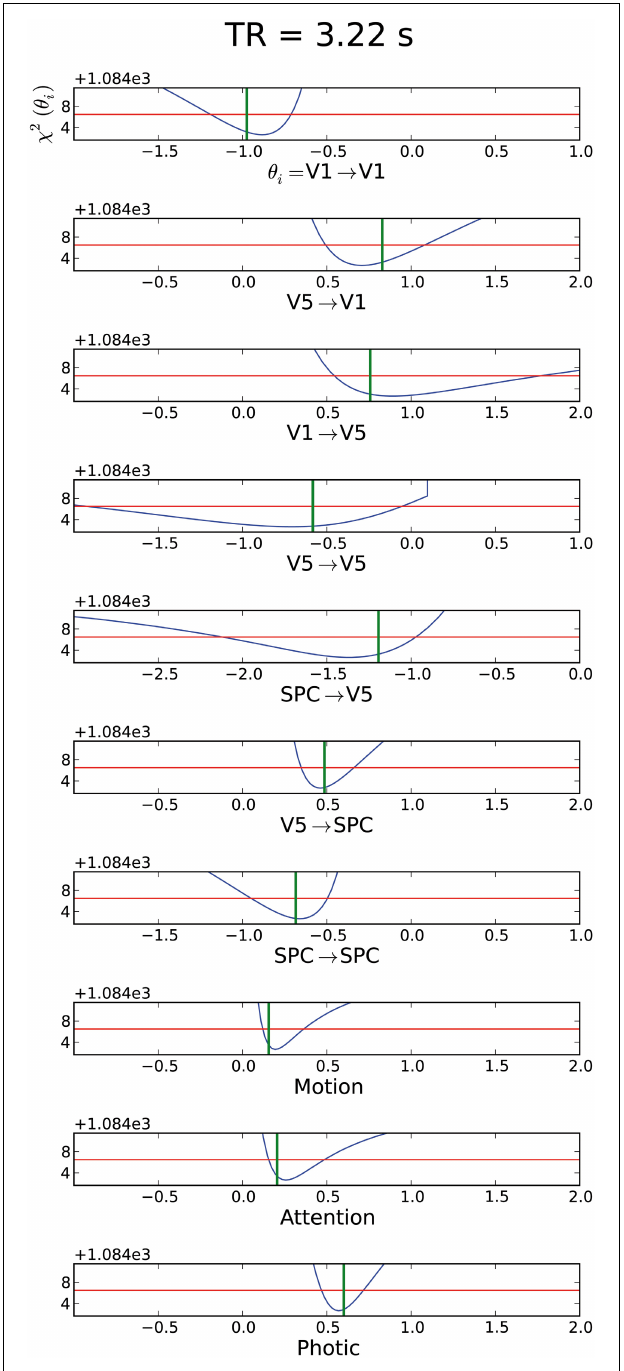
FIGURE 6 | Assessment of the data for the backward model with original settings for TR, epoch duration and session duration with mCI = 0.65. For further explanation of the graphs see Figure 2